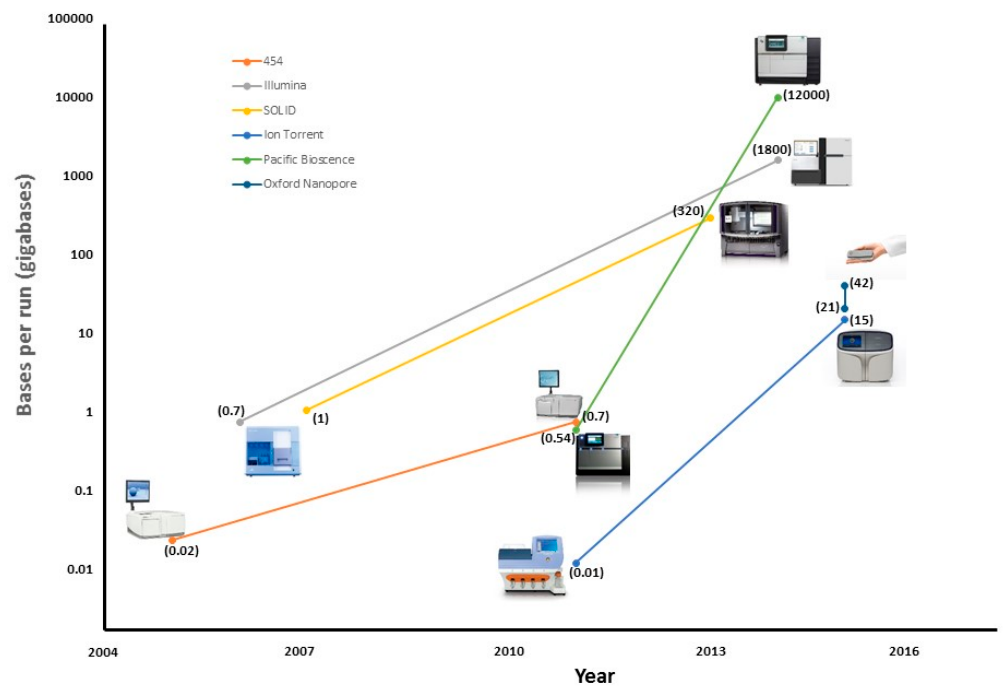
Figure 2. Timeline of the reading capacity of each platform.